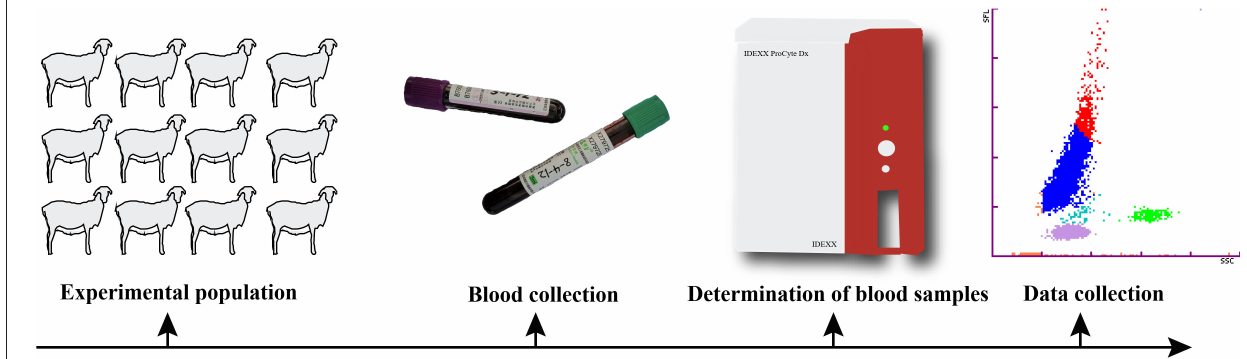
FIGURE 1 | Schematic diagram of the experimental protocol.